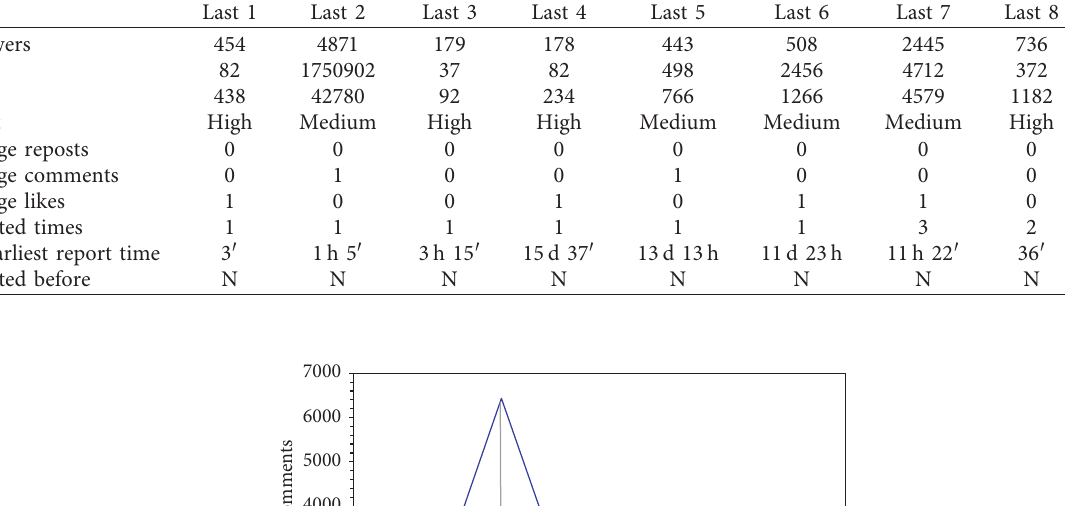
Table 6: Accounts information in the last-10 set.